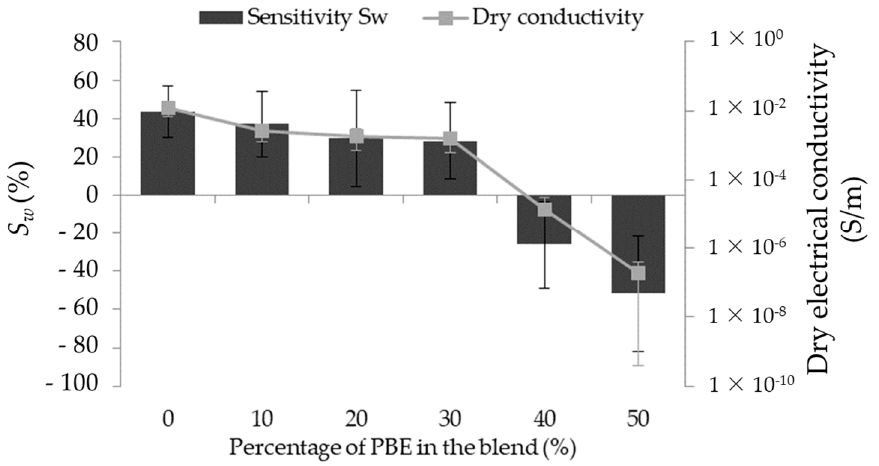
Figure 8. Influence of the proportion by weight of PBE on the water sensitivity of the PA6.6 3CNT /PBE blends.